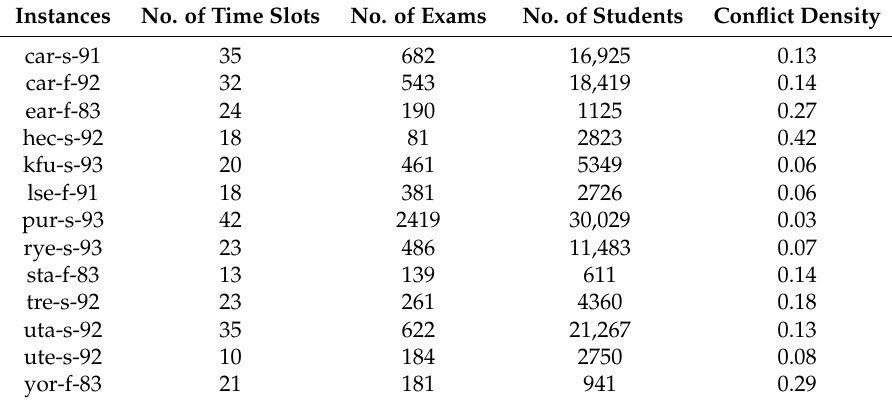
Table 1. Toronto Benchmark